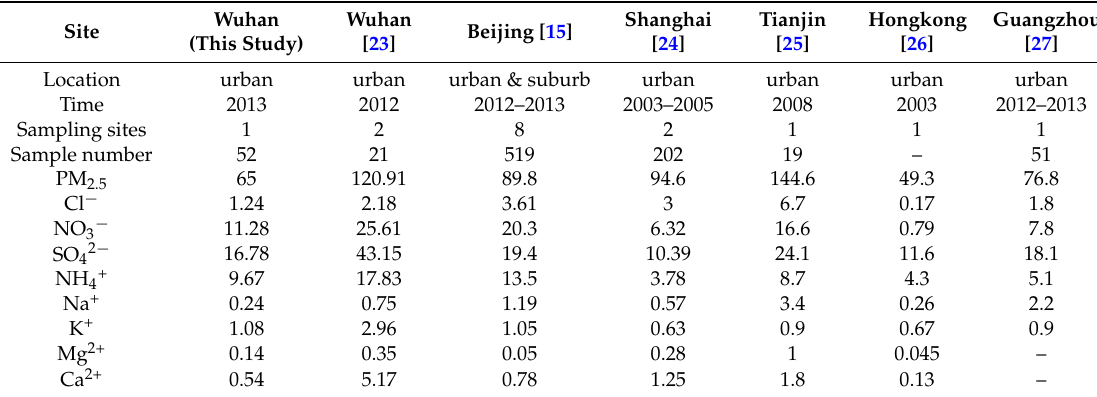
Table 1. Mass concentration of particulate matter (PM 2.5 ) and the water-soluble ions at different sites ( µ g/m ´ 3 ).